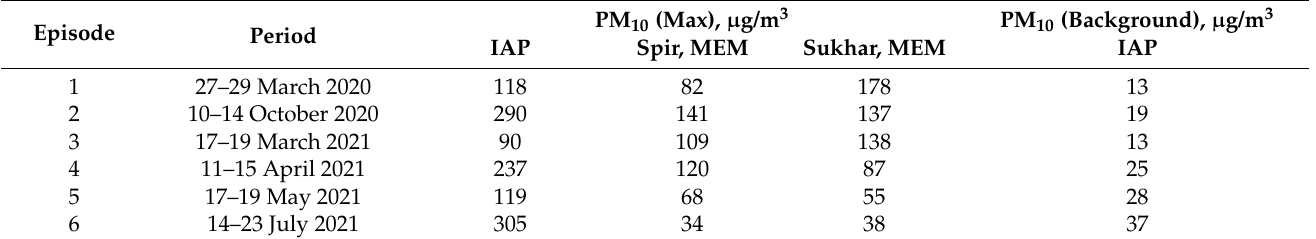
Table 1. Selected episodes with extreme aerosol air pollution in Moscow—at IAP, Spir MEM, and Sukhar MEM. Background–undisturbed level: the average monthly value for the days outside the episodes Nos. 1–5, and the value for Sunday 18 July 2021 without working of the source—for the episode No. 6.